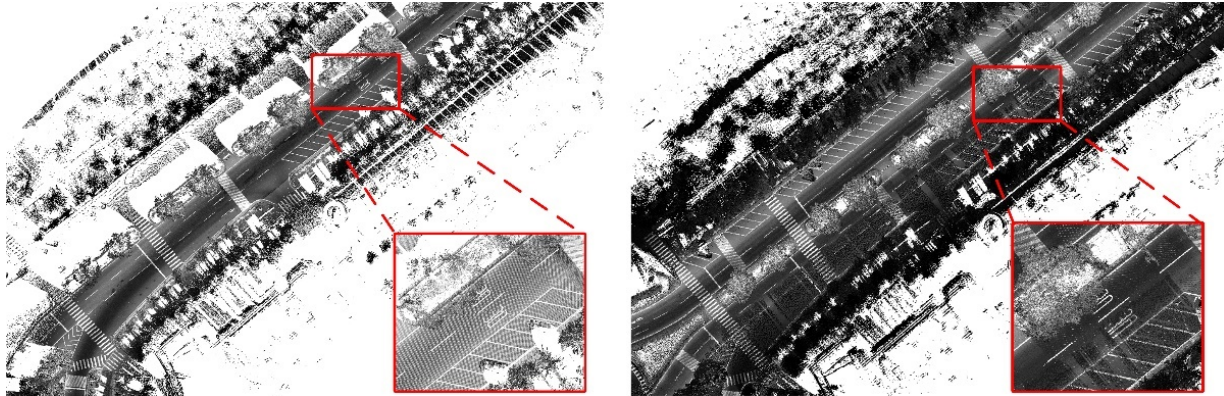
Figure 5. Superposition data in the point cloud.